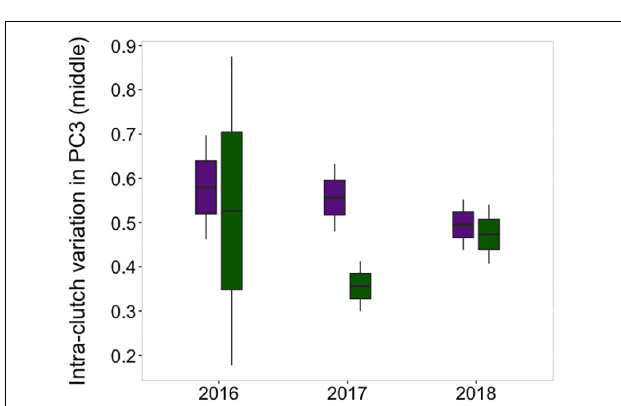
FIGURE 5 | Differences in intra-clutch variation in blue-green egg coloration in the middle area of the eggs between acceptor and rejecter magpies in three different years. Green boxes correspond to rejecter individuals and purple ones correspond to